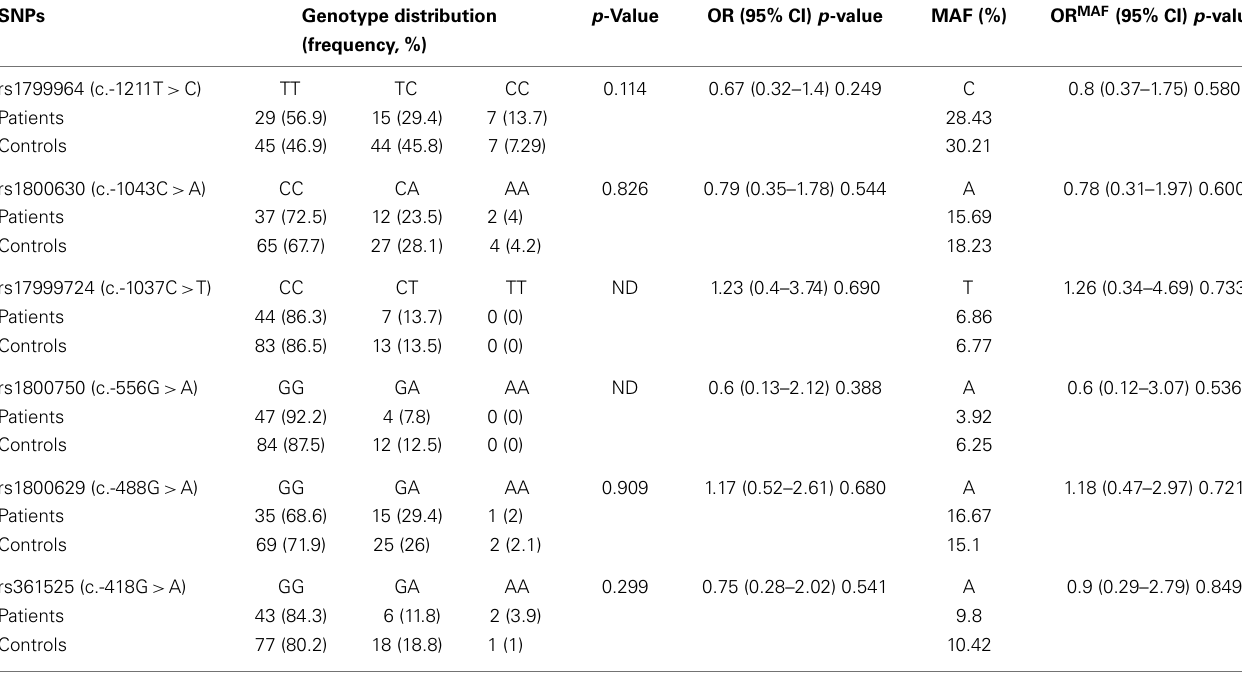
Table 7 |The distribution of TNF - α genotypes in patients with Behçet